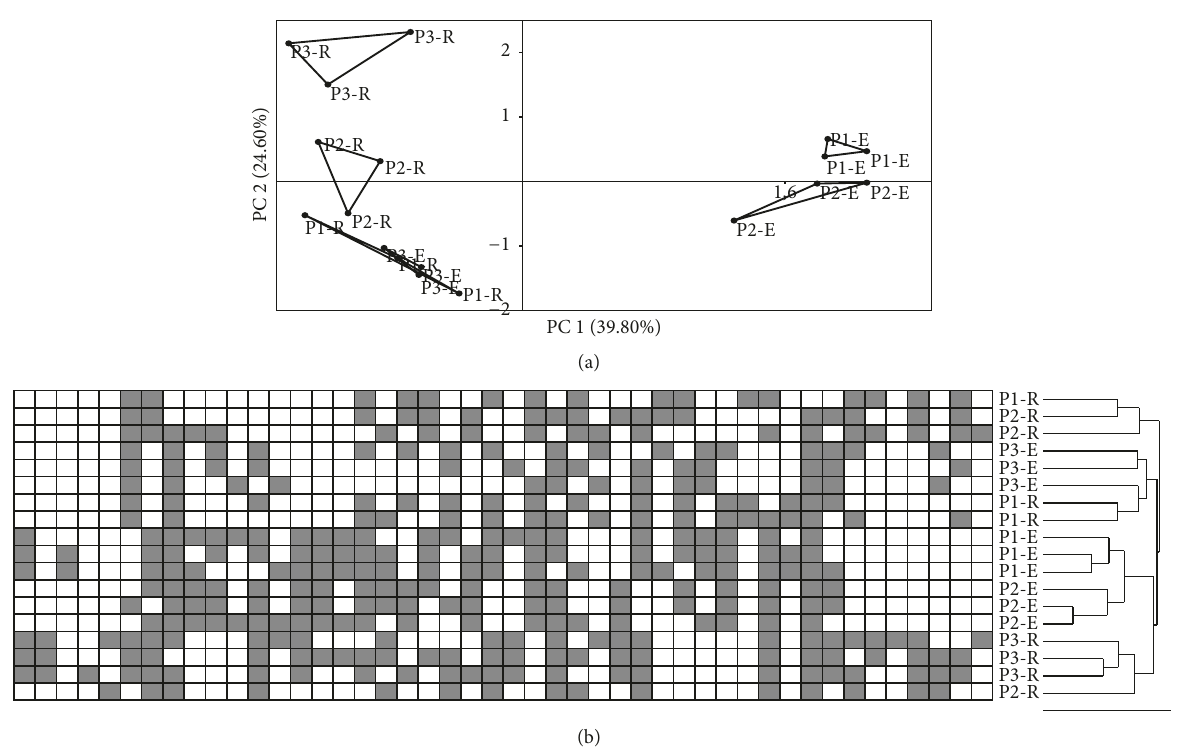
Figure 2: Principal component (PC) analysis (a) and dendogram of the binary matrix (b) of the total diazotrophic bacterial community determined through Denaturing Gradient Gel Electrophoresis (DGGE) of the nif H gene in different regions of the plant/bacteria association in B. decumbens Stapf. pasture in different stages of degradation. P1-R represents the highly degraded pasture and rhizospheric soil niche; P2-R represents the partially degraded pasture and rhizospheric soil niche; P3-R represents the slightly degraded pasture and rhizospheric soil niche; P1-E represents the highly degraded pasture and root-endophytic niche; P2-E represents the partially degraded pasture and root- endophytic niche; and P3-E represents the slightly degraded pasture and root-endophytic niche.